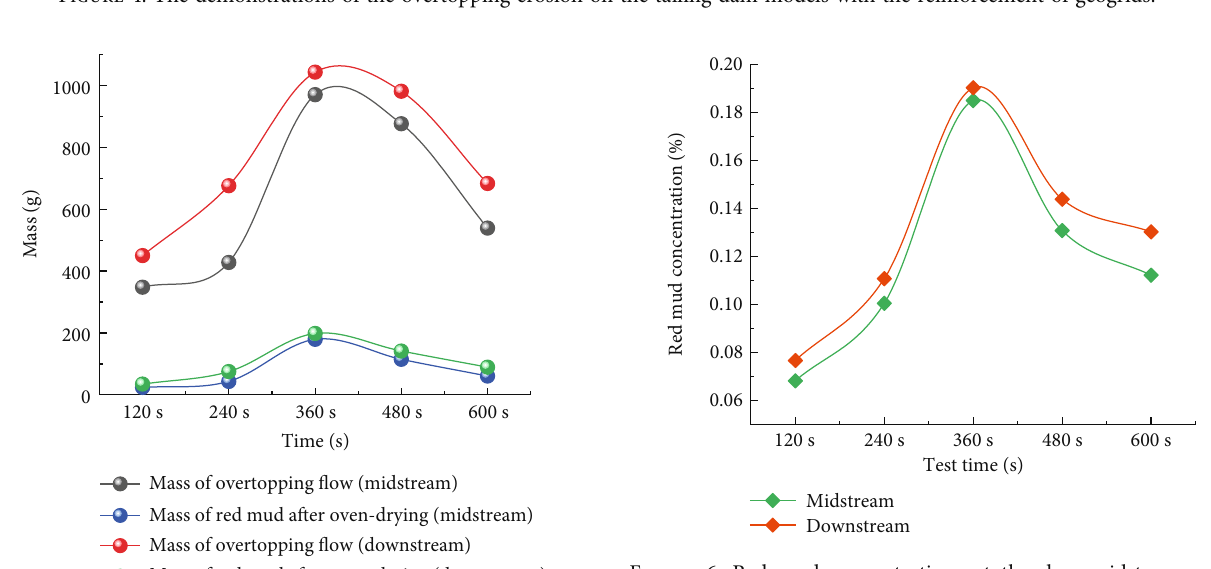
Figure 4: The demonstrations of the overtopping erosion on the tailing dam models with the reinforcement of geogrids.